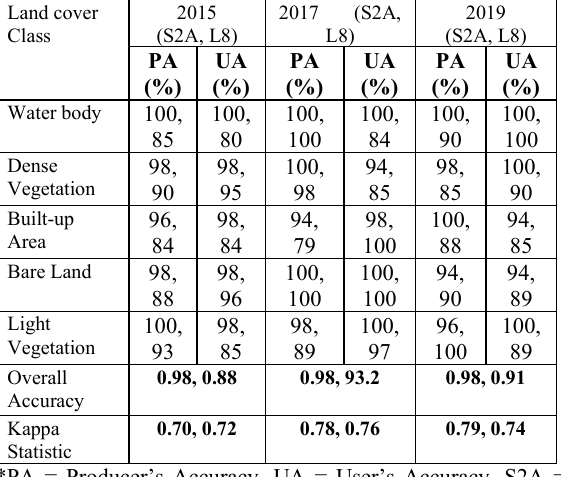
Table 4: Classification Accuracy Assessment